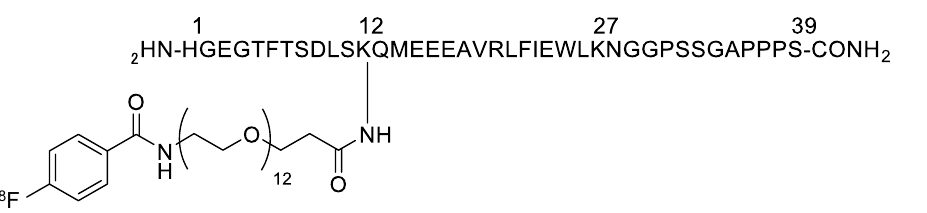
Figure 6. Chemical structure of [ 18 F]FB(ePEG12)12-exendin-4. A chemical structure of [ 18 F]FB(ePEG12)12- exendin-4 is shown. Exendin-4 was conjugated with polyethylene glycol (PEG) and [ 18 F]succinyl-4- fluorobenzoate